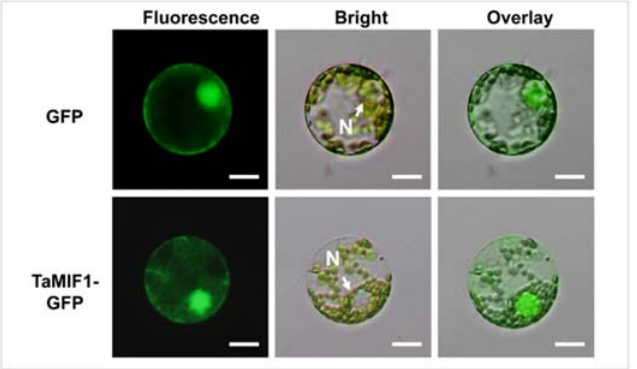
Figure 3. Subcellular localization of TaMIF1. Subcellular localization of TaMIF1–GFP was observed in wheat mesophyll protoplasts with GFP as control. Overlay is a combination of both fluorescence and bright field. N: nucleus. Bars = 50 μ m.